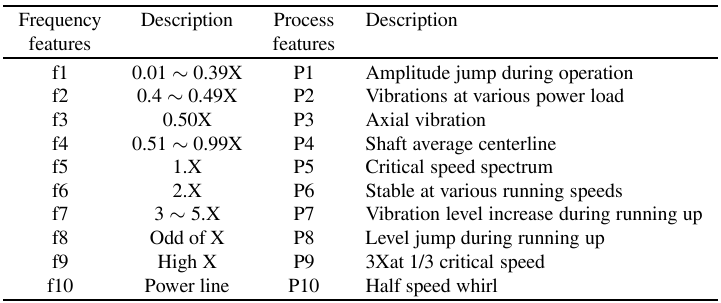
Table 1 Symbols for Vibration Frequency and Process Feature